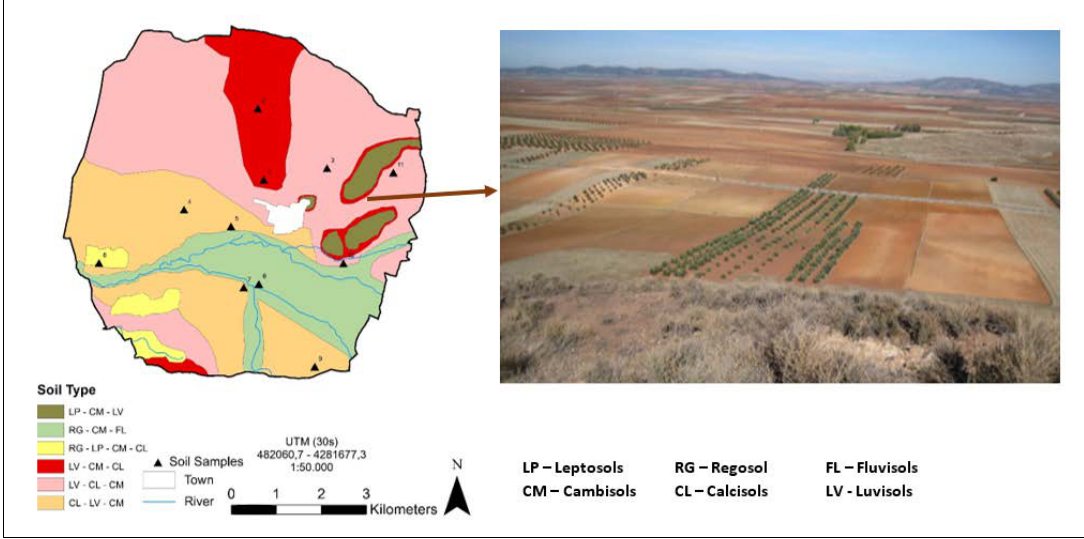
Figure 2. Schematic soil map of the Alcubillas municipability. Detail of spatial variability at metric or decametric scale.